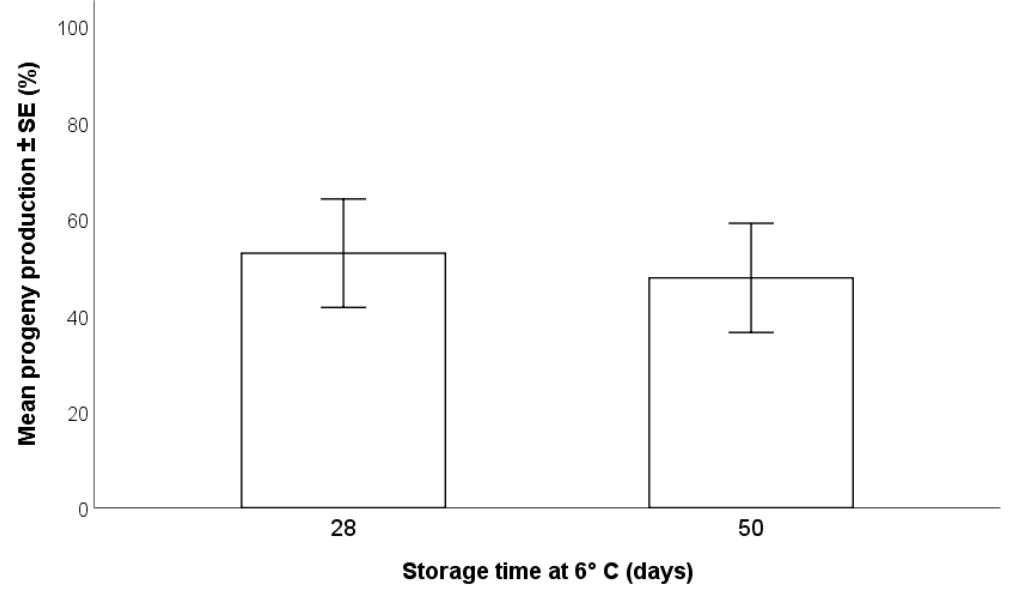
◦ C on the production of progeny by Trissolcus japonicus (GLMM, p > Figure 2. Effects of storage time at 6 °C on the production of progeny by Trissolcus japonicus (GLMM, p > 0.05). Figure 2. Effects of storage time at 6